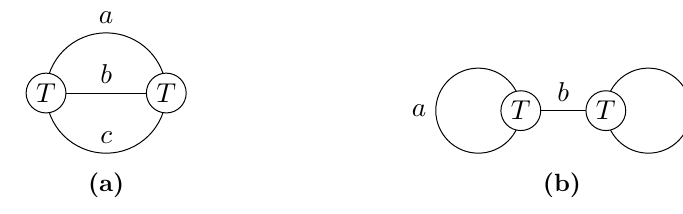
Figure 12. The two generic types of g = 2